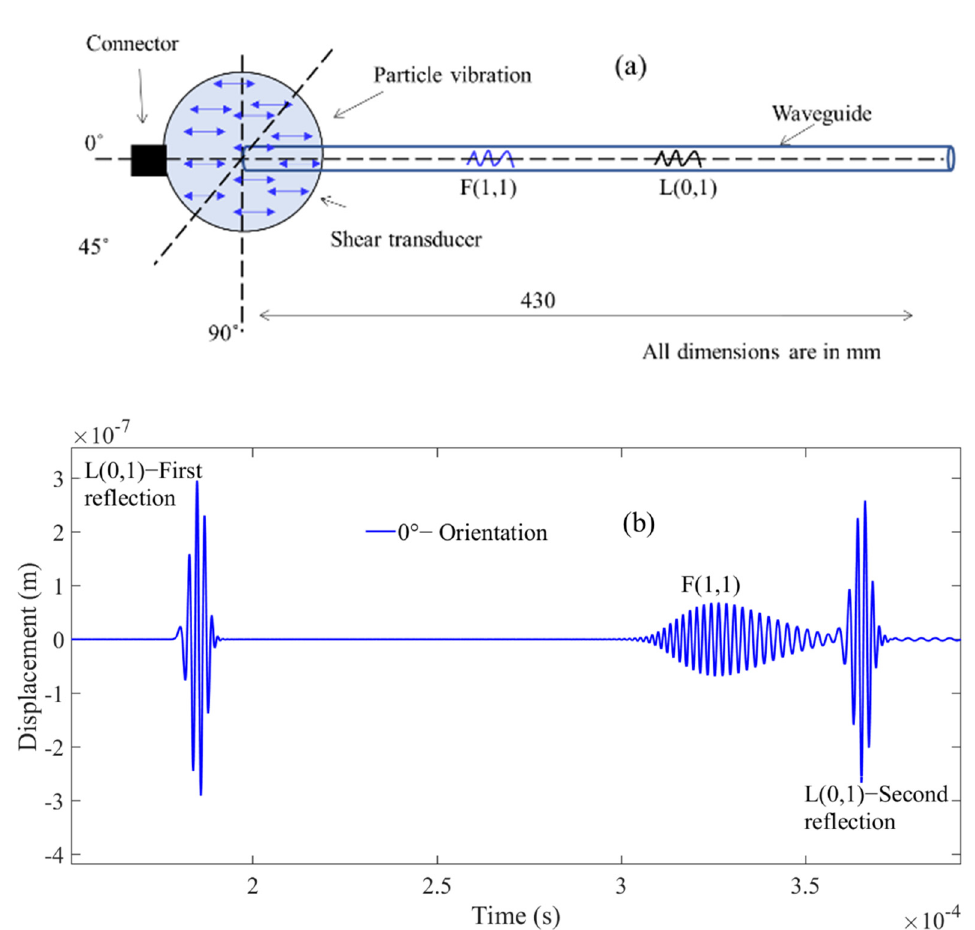
Figure 3. ( a ) Shows the shear transducer orientation (0°) to the waveguide axis ( b ) and the reflected A-Scan signals from FEM simulations with L(0,1) and F(1,1).